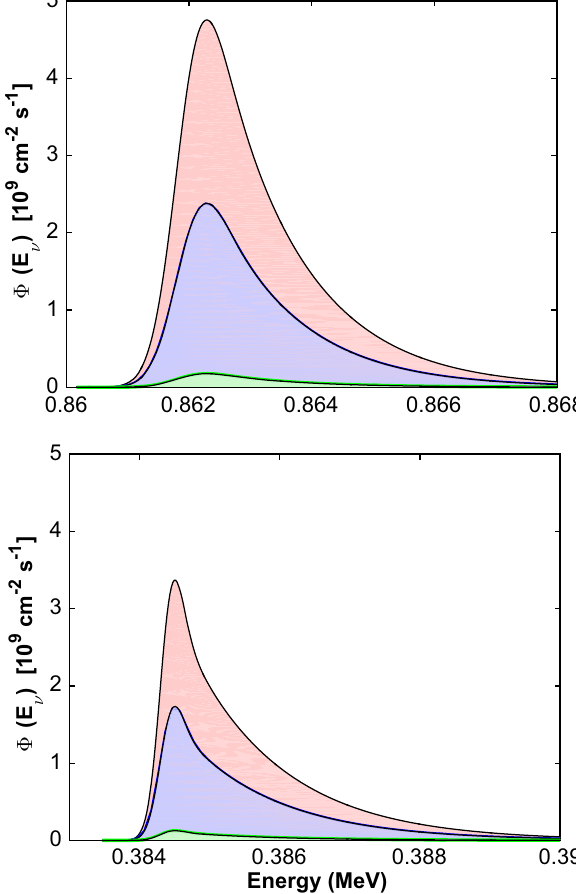
Fig. 8 Neutrino of the two line spectra of 7 Be nuclear reaction. The colour scheme is the same used in Fig.